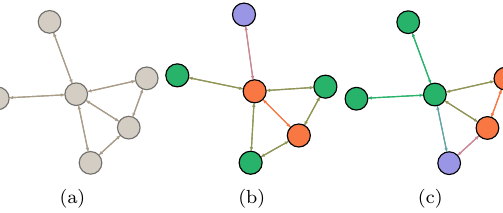
Figure 1. Three examples of the same network design: ( a ) A monoculture network; ( b ) a multiculture network composed of three different technologies, where nodes were located improperly; ( c ) a multiculture network composed of three different technologies, where nodes are located to maintain connectivity in the face of a class